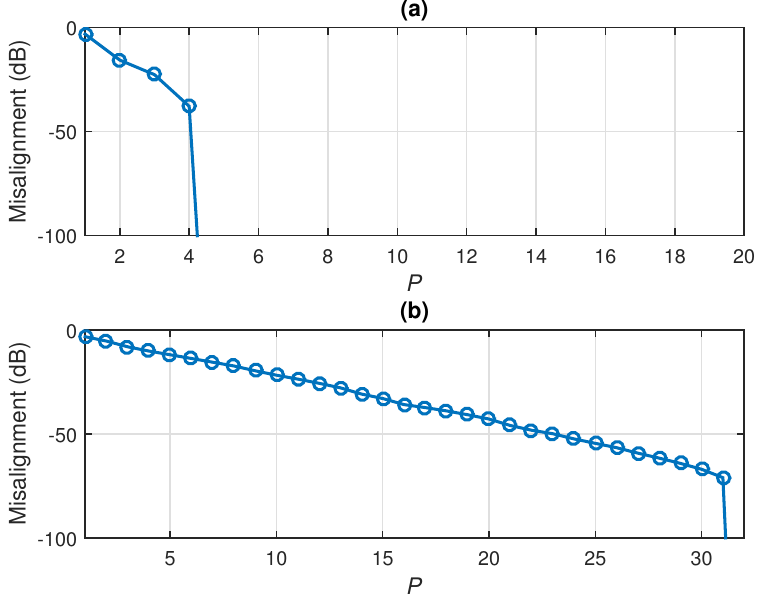
Figure 5. Normalized misalignment evaluated based on (55) for different values of P , corresponding to ( a ) the impulse responses from Figure 3, with M = 4, L = 500, L 1 = 25, and L 2 = 20; and ( b ) the impulse responses from Figure 4, with M = 2, L = 1024, and L 1 = L 2 = 32. For better visualization, the representation is limited to − 100